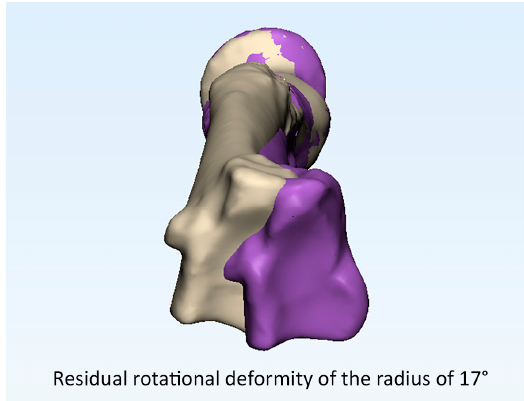
Figure 4. Example of a non-anatomic correction of the radius.